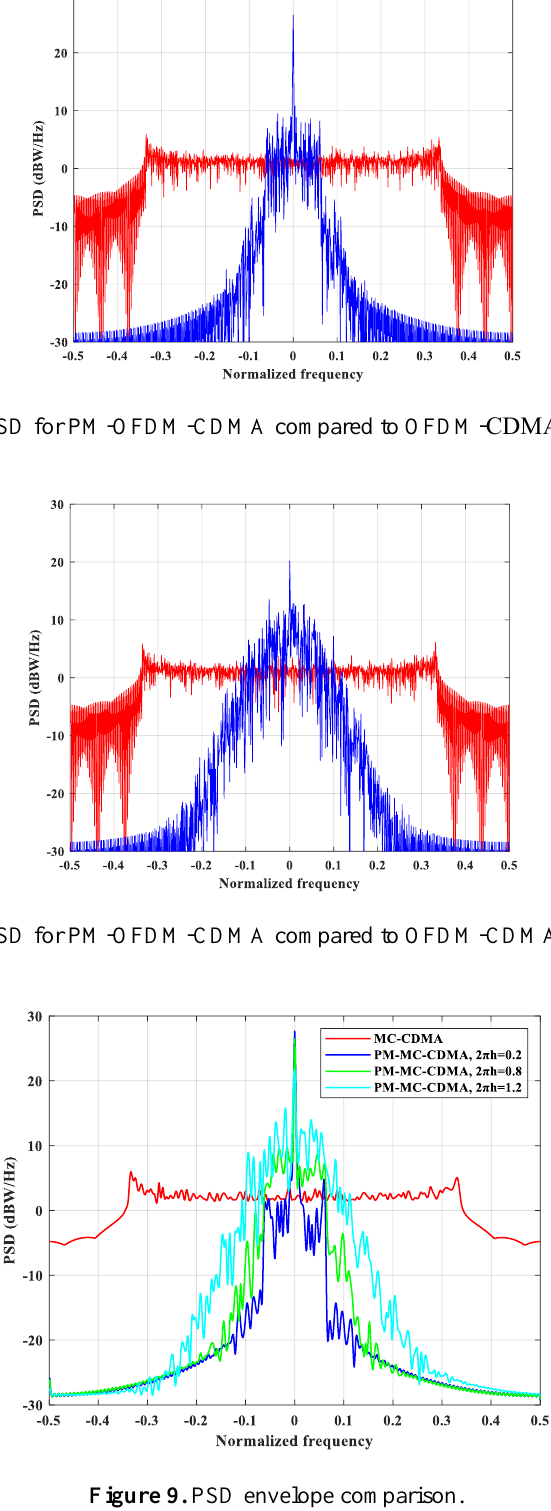
Figure 9. PSD envelope 1109 | Vol. 6, No. 4, 2021